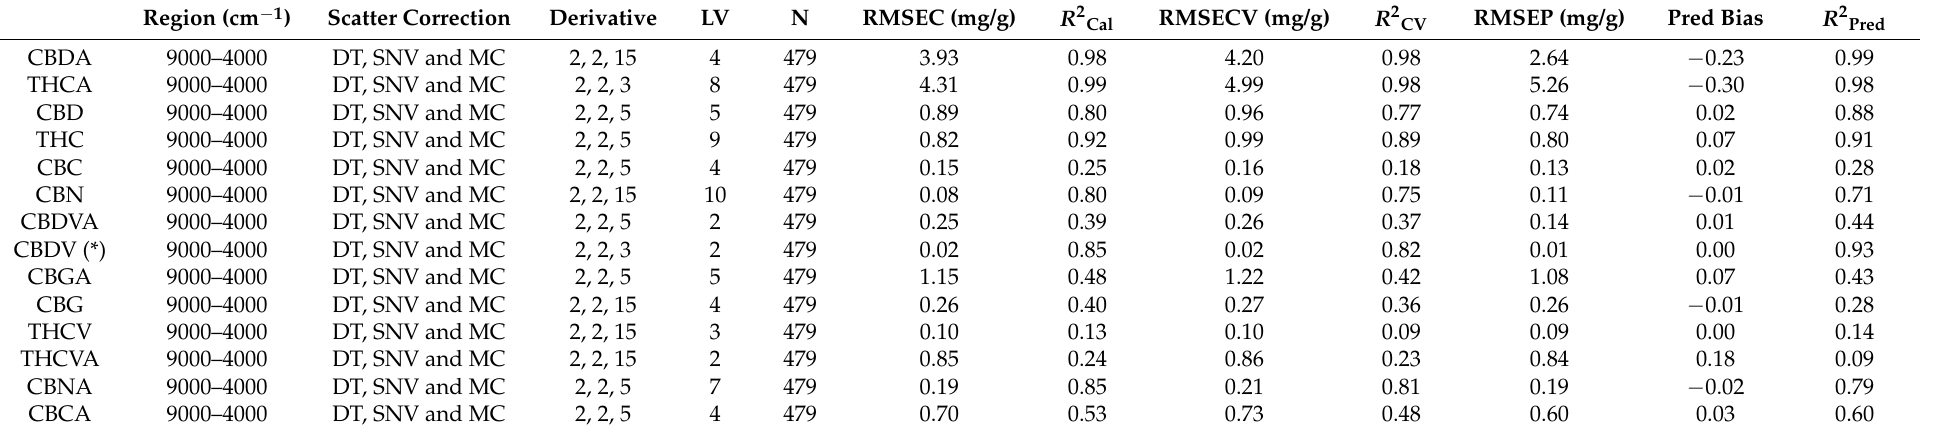
Table 6. Calibration and validation values of partial least squares regression models on finely ground cannabinoid compounds analysed by the Bruker MPA II instrument.